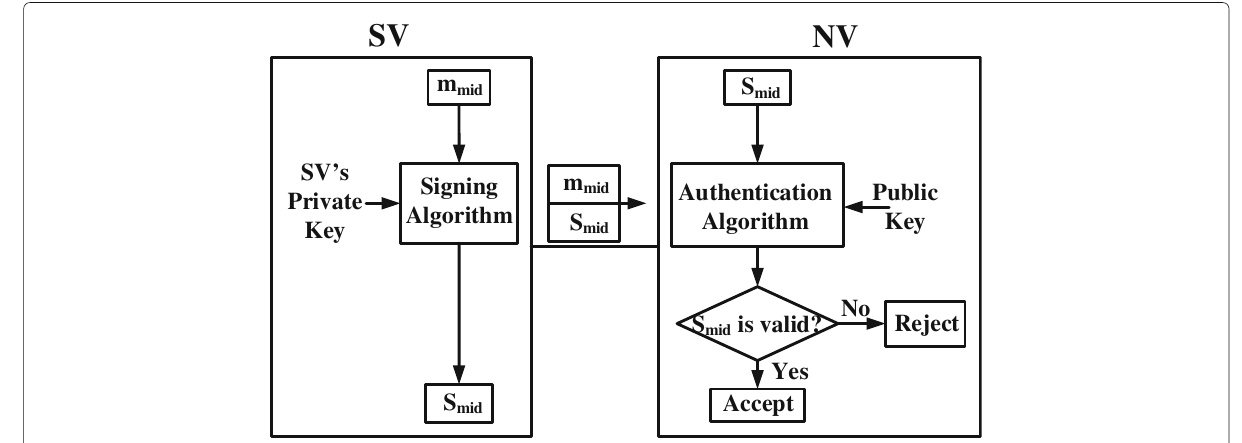
Fig. 2 The flowchart of message signing and